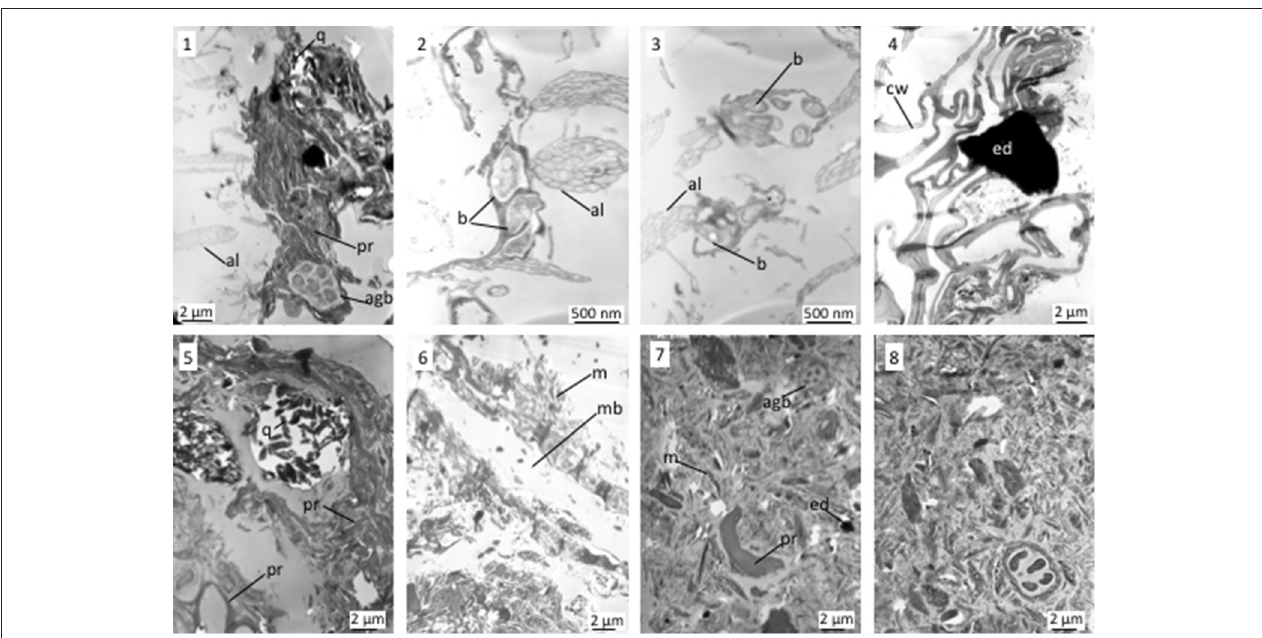
FIGURE 4 | TEM views of granulometric fractions of the amended soil 1–3 : alveolar MPs associated with soil aggregate or bacteria; 4 : electron-dense MPs projected on plant residue; 5, 6 : 20–50 µ m organo-mineral fraction and membrane structured MPs associated to organo-mineral fraction (7.6); 7 : 2–20 µ m fraction showing an electron-dense MPs; 8 : 0–2 µ m fraction. agb, bacterial aggregate; al, alveolar MPs; b, bacteria; cw, cell wall; ed, electron dense MPs; m, mineral; mb, membrane structured MPs; pr, plant residue; q,